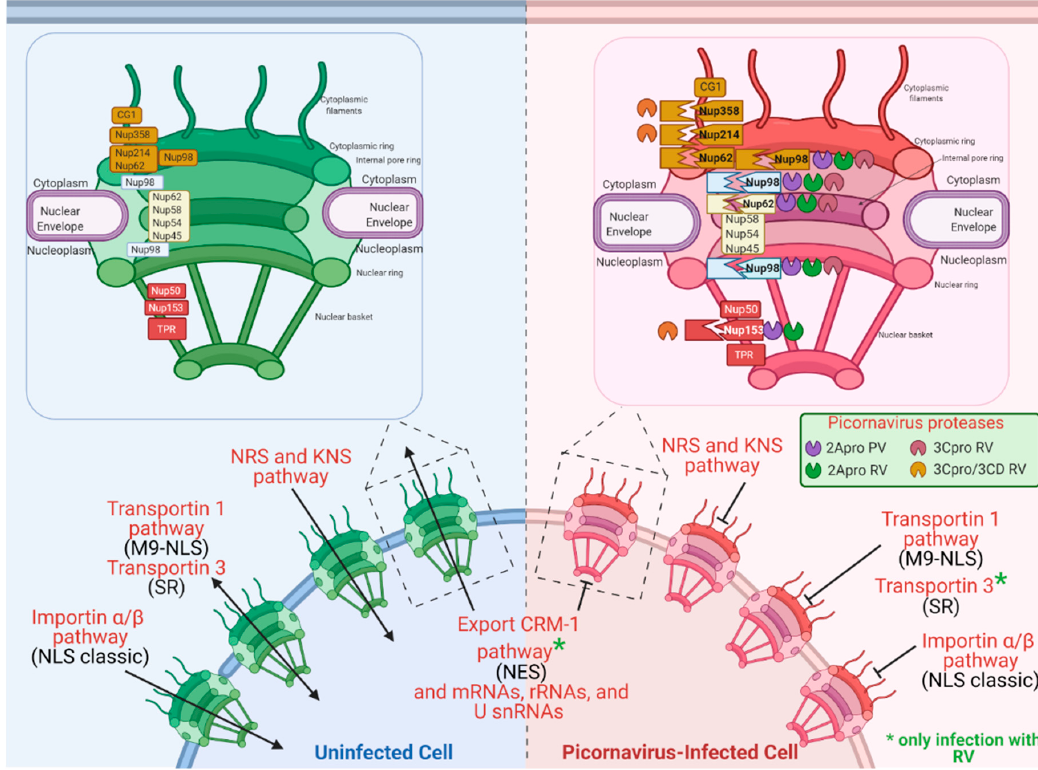
Figure 5. NPC alterations by Poliovirus and Rhinovirus 2Apro and 3Cpro activity and cleavage consequences. Nups cleavages made up by 2Apro, and 3Cpro of RV and PV are shown. Some nuclear import and export pathways are shown in uninfected and RV and PV-infected cells. Inhibition of pathways of import and export nuclear are shown.